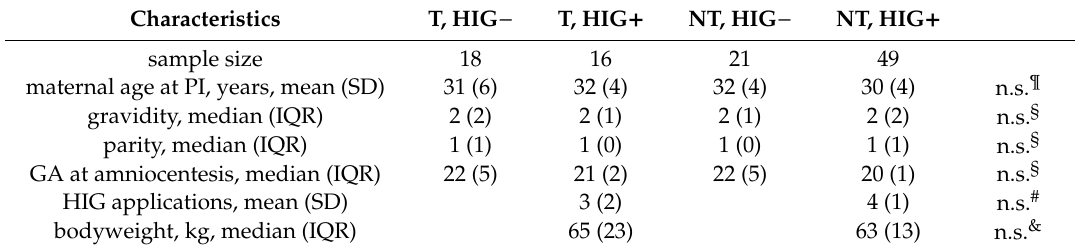
Table 1. Subcohort characteristics stratified by treatment with HIG and CMV transmission status. Characteristics T, HIG